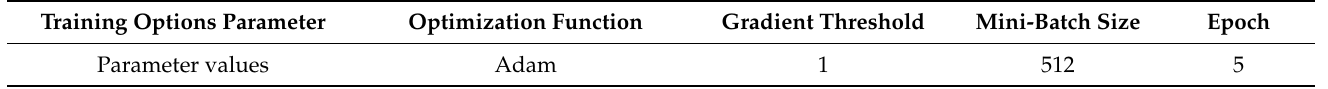
Table 4. Learning parameters of CNN transfer learning